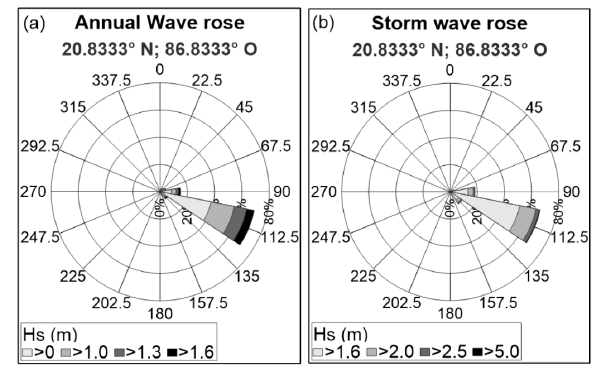
Figure 8. Wave roses: ( a ) annual; ( b ) storm conditions.